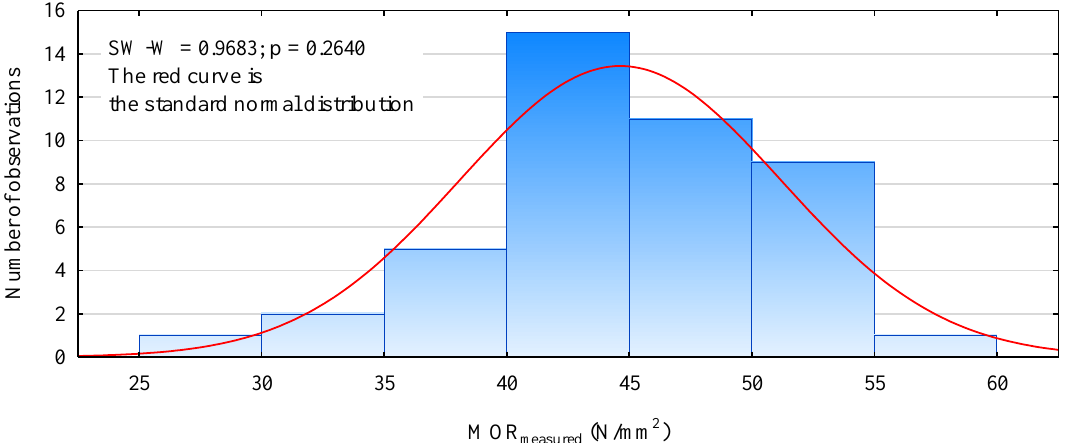
Figure 4. A histogram of the static bending strength for the glued beams made of mechanically graded timber.